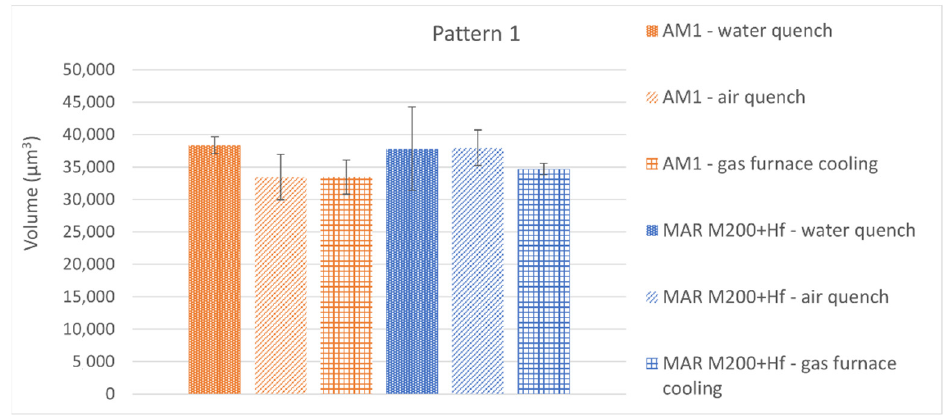
Figure 12. Thermally affected volumes of textured pattern 1 on AM1 and MAR M200 + Hf as a function of cooling kinetics.